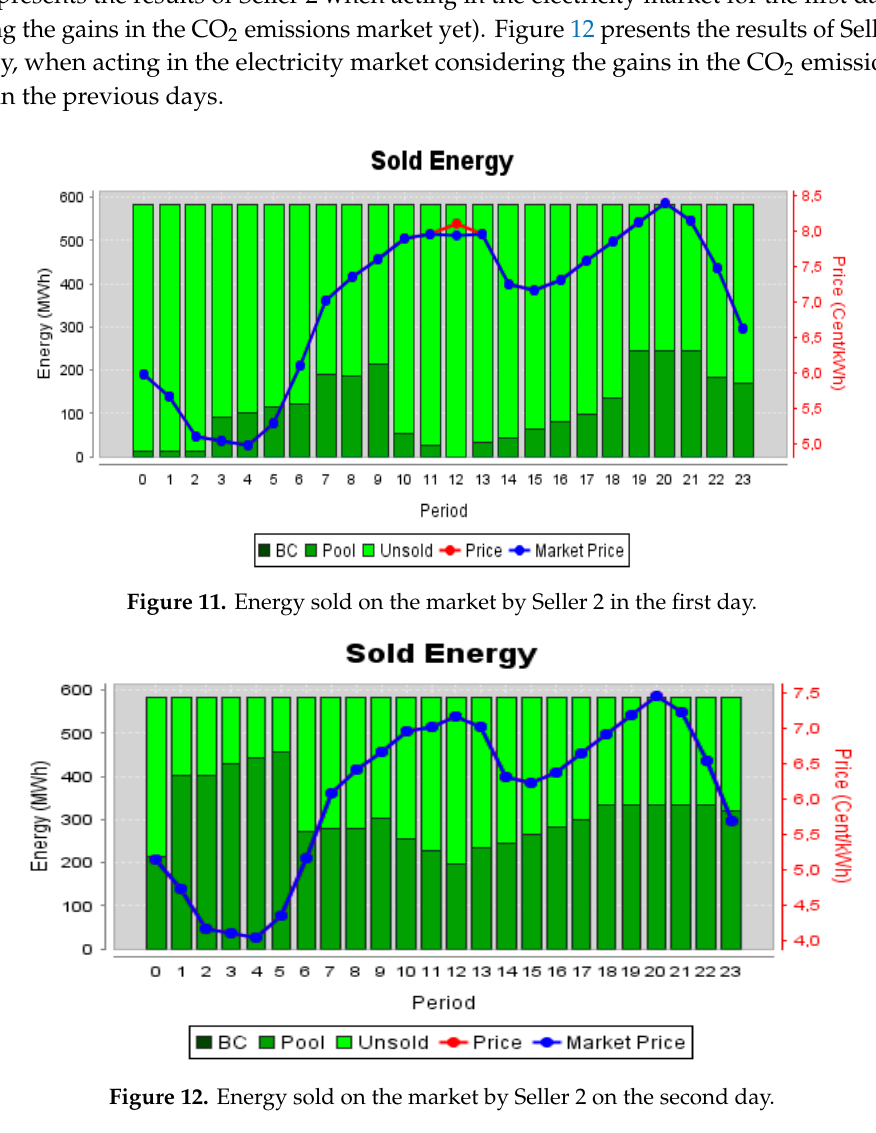
Figure 12. Energy sold on the market by Seller 2 on the second day.